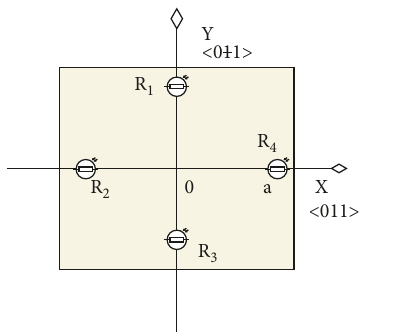
Figure 9: Schematic diagram of the shape of the silicon film.